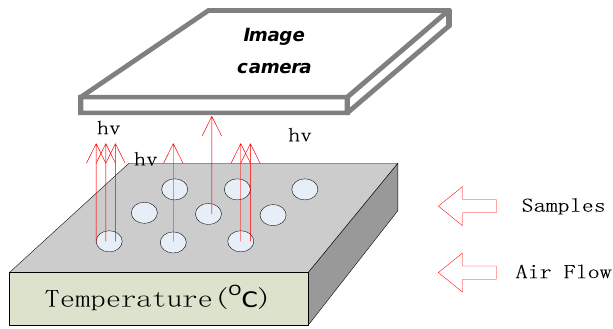
Figure 1. Brief structure of the CTL sensor